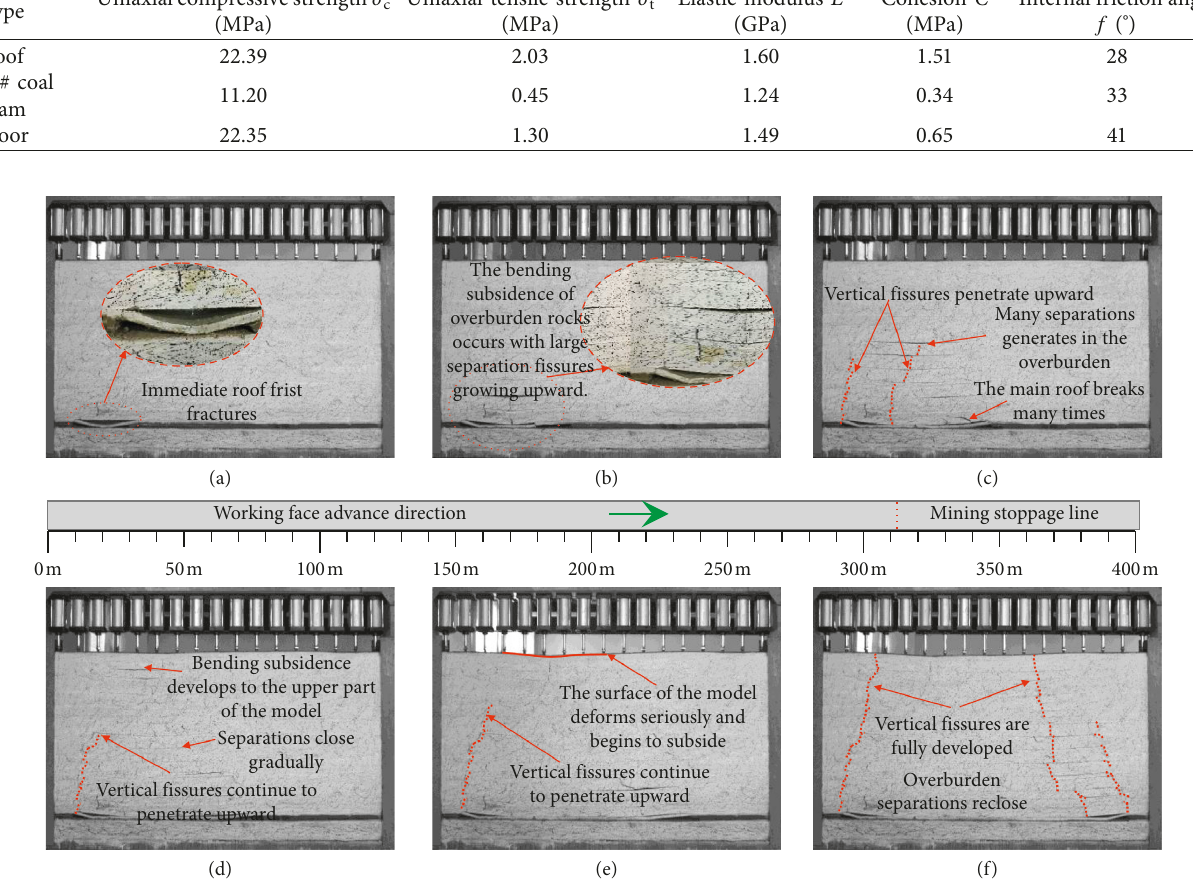
Figure 9: Evolutionary characteristics of overburden fissures and separations: (a) 12.5m, (b) 55m, (c) 117m, (d) 210m, (e) 242m, and (f) 315m.